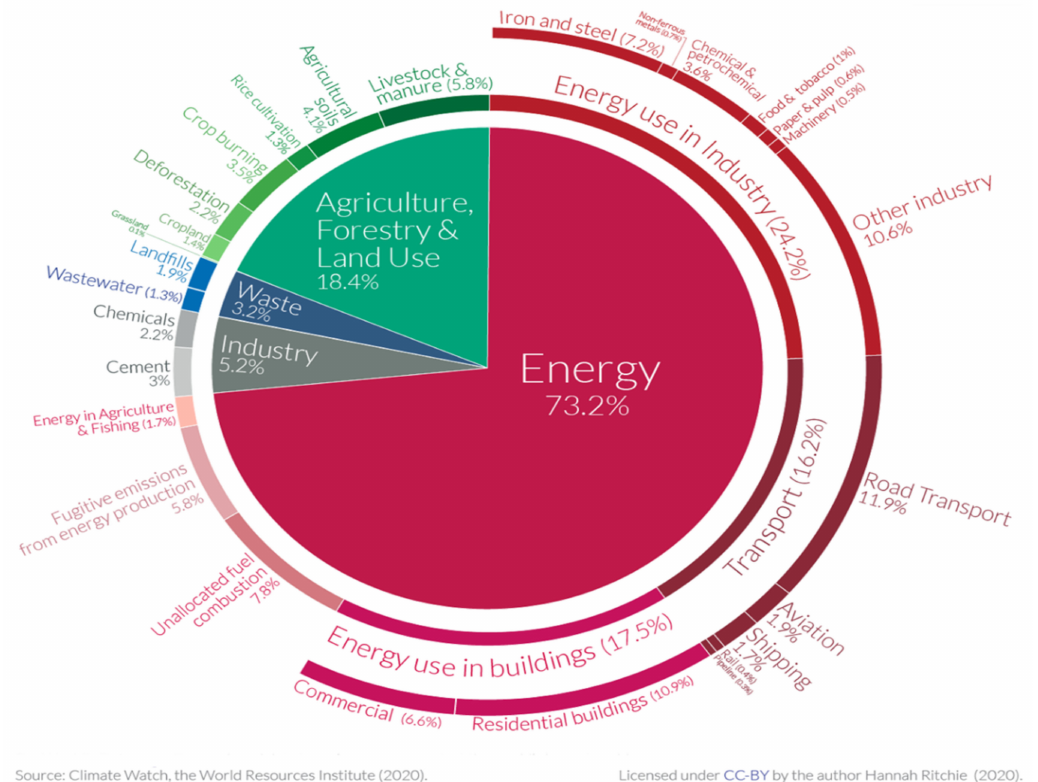
Figure 1. Global greenhouse gas emission by sector for 2016. Total greenhouse gas emissions were 49.4 billion tonnes CO 2 equivalent